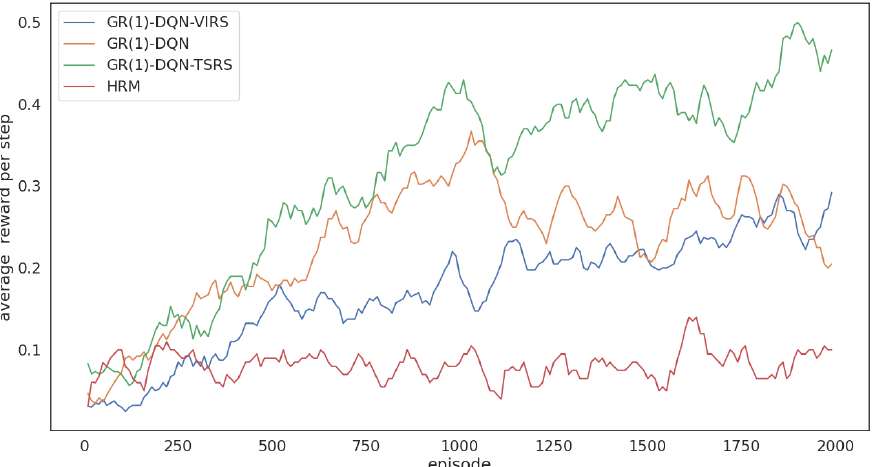
Figure 6. Comparison of learning curves for multi-task reinforcement learning algorithms with ϕ 2 under the same stochastic environment.